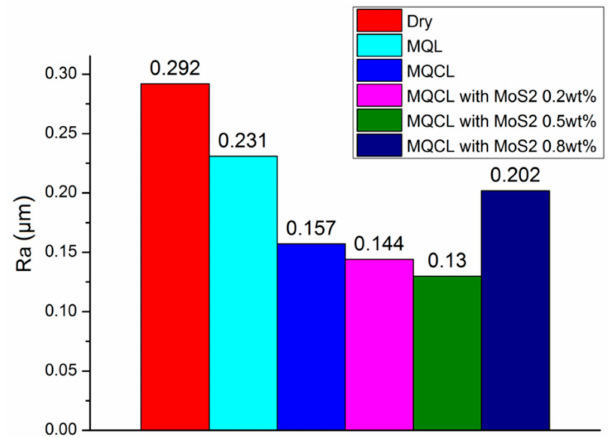
Figure 8. The average values of surface roughness R a under di ff erent